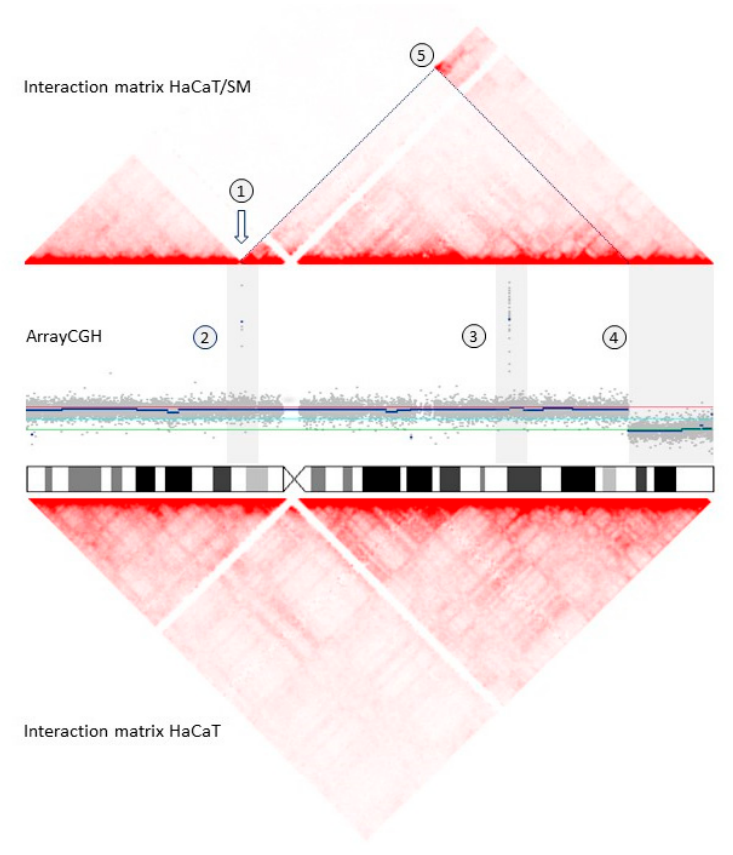
Figure 5. Changes in DNA copy number and chromatin conformation suggest complex rearrangement of chromosome X. Triangular Hi-C interaction matrices for HaCaT/SM and HaCaT are plotted above and below the array CGH log 2 ratio plots. Increased red color saturation at the tip of a triangle connecting two genomic positions at the base line indicates higher interaction probability (exemplarily highlighted in the Hi-C results of HaCaT/SM by dashed lines): (1) translocation breakpoint t(11;X); (2) small deletion (chrX: 48,928,825–48,942,873) adjacent to the translocation breakpoint; (3) deletion chrX:109,358,110–109,515,685; (4) duplication chrX:148,572,165–155,257,126; (5) increased chromosomal interaction probability indicating spatial proximity of the chromosomal duplication and translocation breakpoints (highlighted by gray dashed lines). Chromosome coordinates refer to